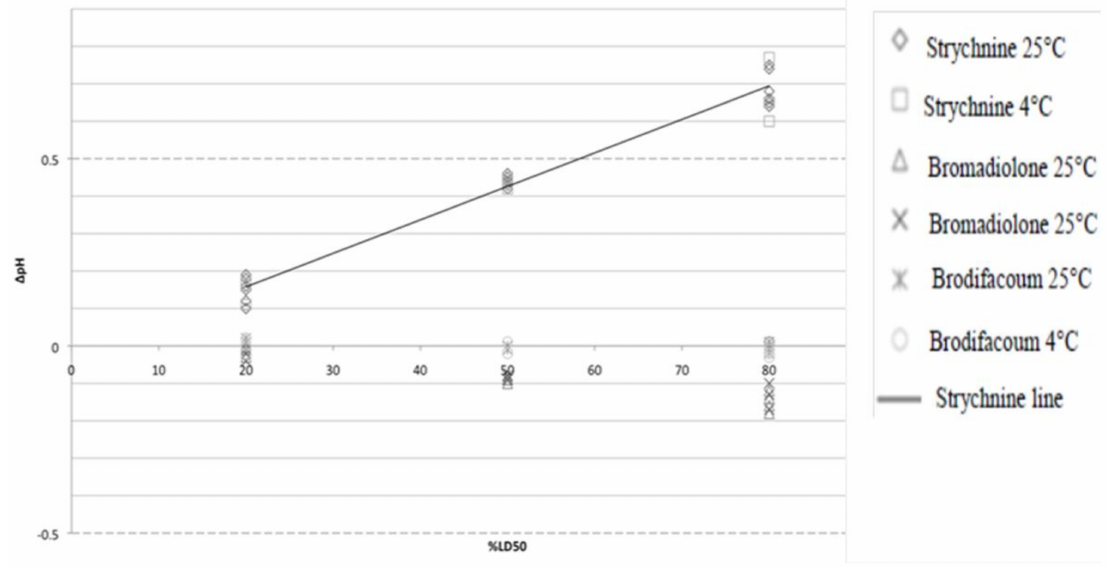
Figure 1. The effect of rodenticides on pH at 4 ◦ C and 25 ◦